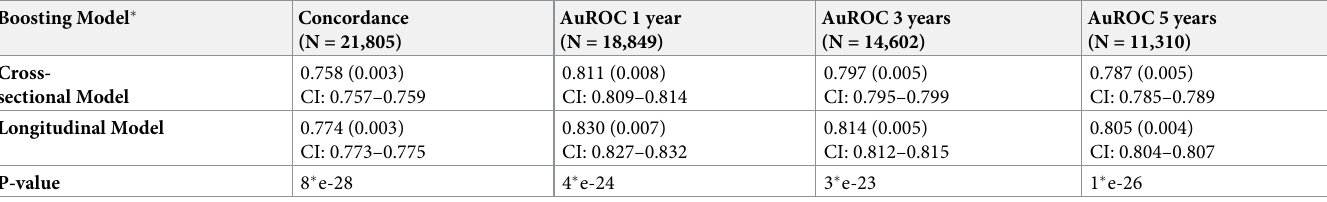
Table 3. Performance of boosting